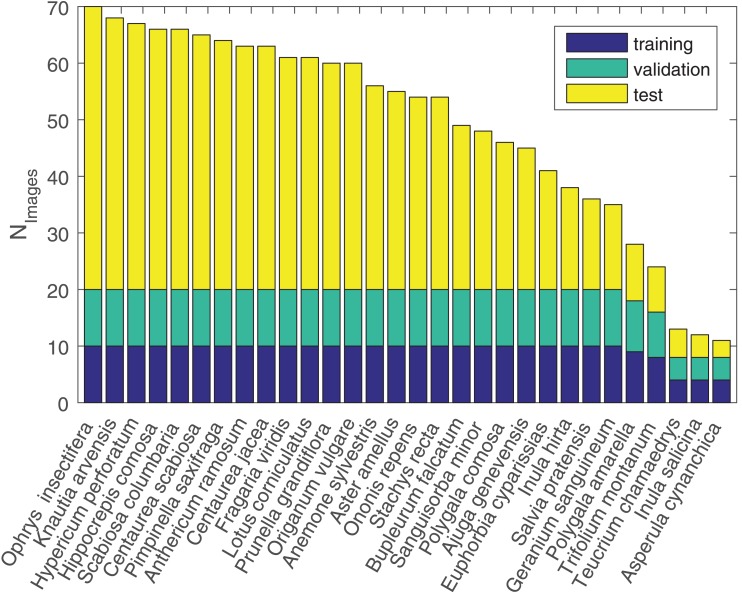
Images per species within the Jena Flower 30 (JF30) dataset.